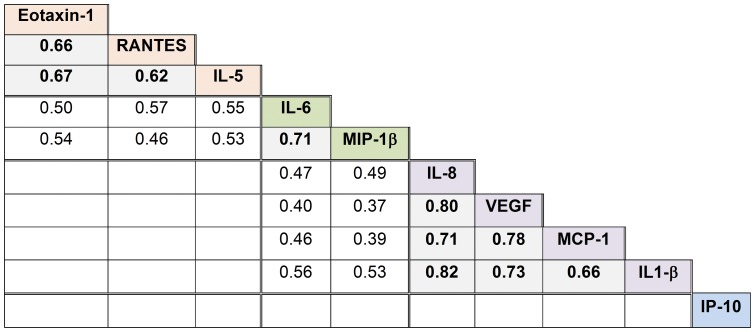
Correlation matrix for 10-analyte salivary inflammatory marker panel.The mean of the pediatric and adult populations' Pearson's correlation coefficients for each pairwise correlation of log10 transformed salivary markers is displayed. Correlation coefficients are displayed if p<0.01 for both pediatric and adult populations for the pairwise relationship. Bolded correlation coefficients are >0.6.